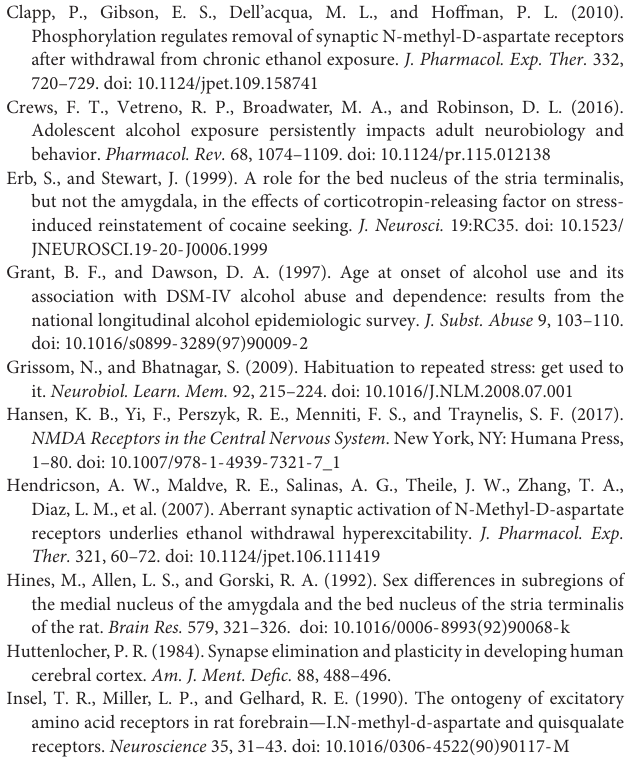
FIGURE S1 | Original source data for electrophoretic blots shown in Figures 2A–F . The sample bands shown in Figures 2A–C were taken from the three blots shown in male mice section A , row 1. One sample was removed from data analysis because of lane contamination (indicated by the “x” in row 4 of the GluN2B column). The sample bands shown in Figures 2D–F were taken from the three blots shown in female mice section B , row